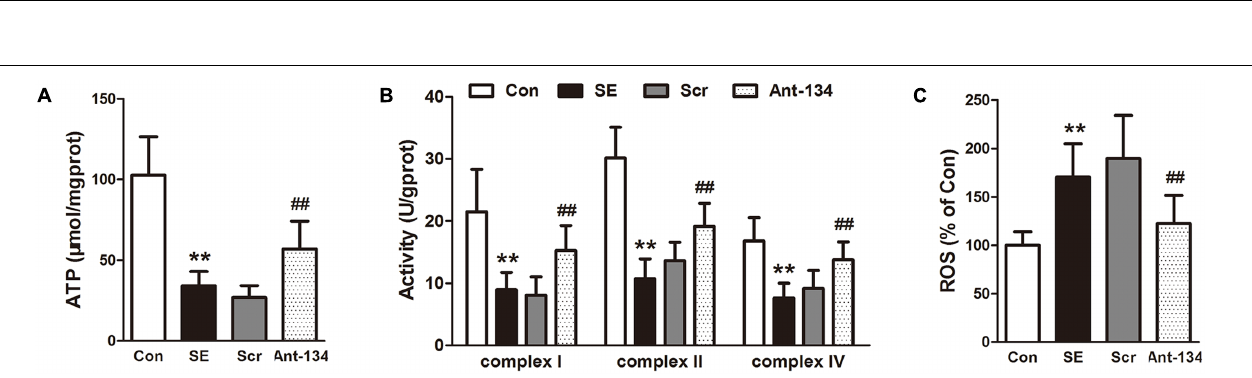
FIGURE 4 | Effects of Ant-134 on oxidative stress in the hippocampus of the SE rats. Treatment of Ant-134 significantly decreased (A) MDA and (B) HNE production and increased (C) SOD activity. Data are expressed as mean ± SD, n = 6. ∗∗ p < 0.01, versus the control group, ## p < 0.01, versus the SE group.